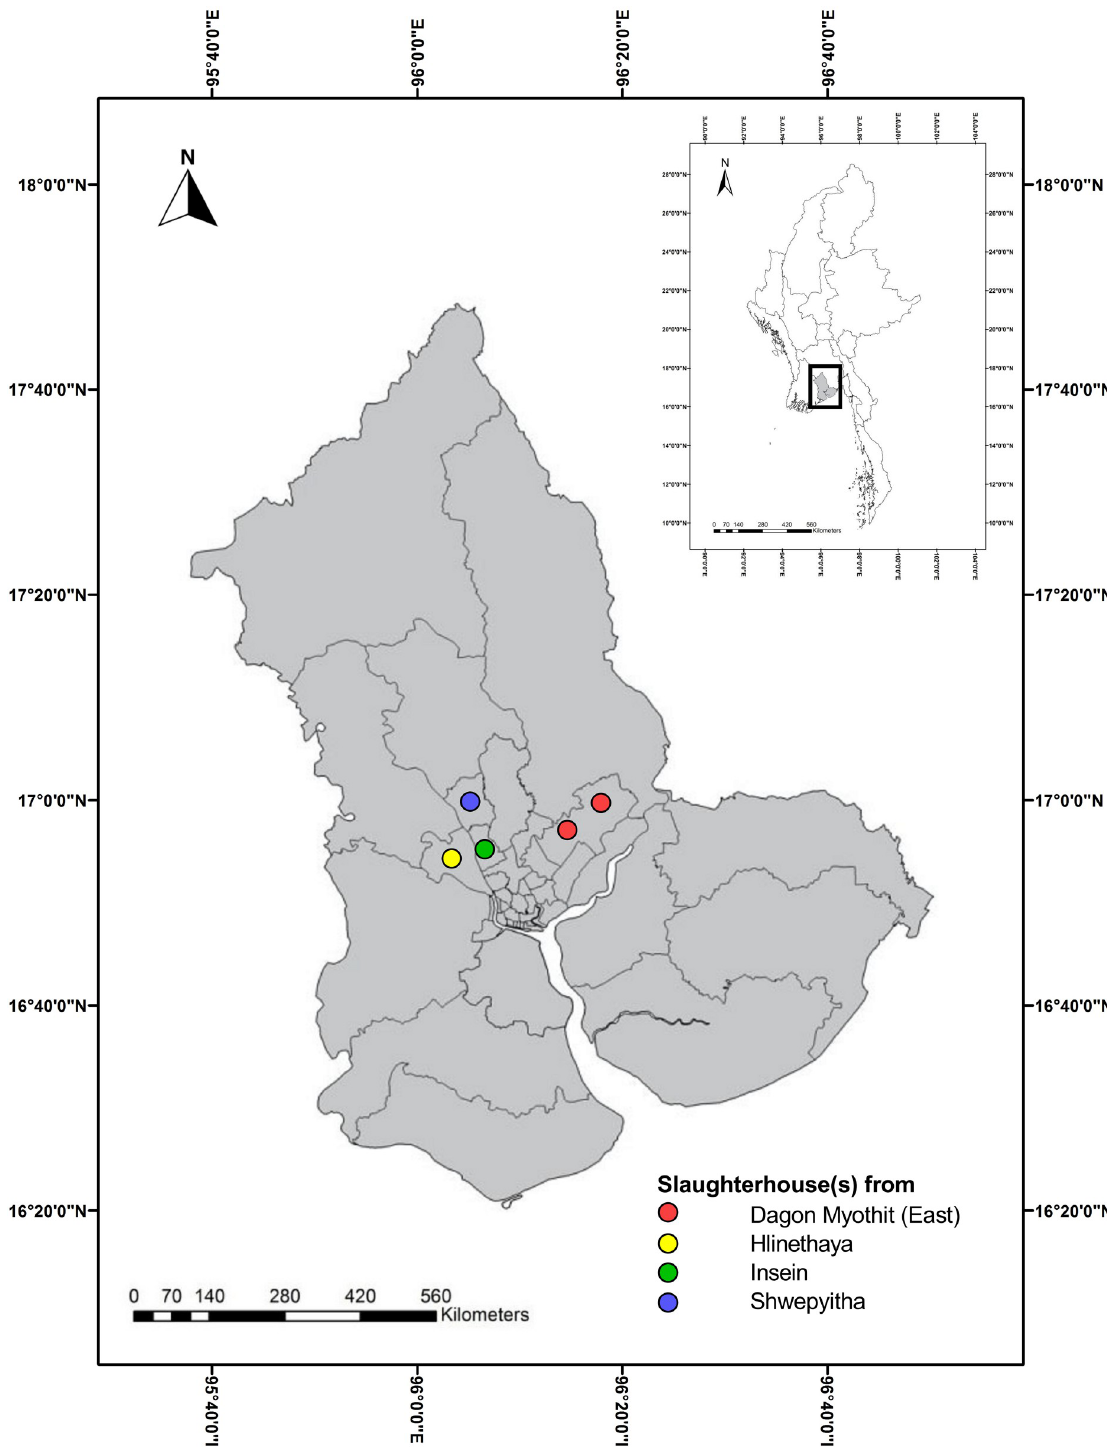
Fig 1. Map of the location of main slaughterhouses, Yangon Region, Myanmar (study area). This is an original figure created using ArcGIS and the link to map base layer used in creating this figure: http://geonode.themimu.info/layers/?limit=100&offset=0”.